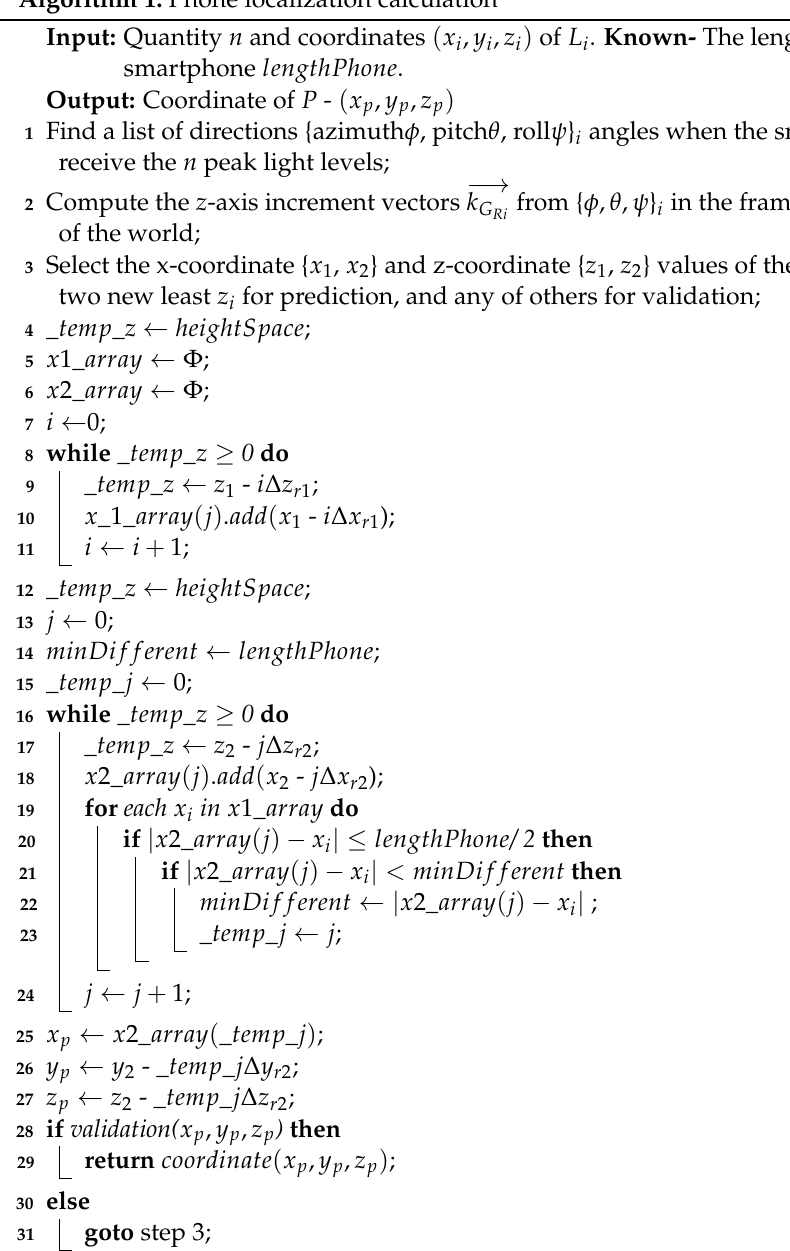
Algorithm 1: Phone localization